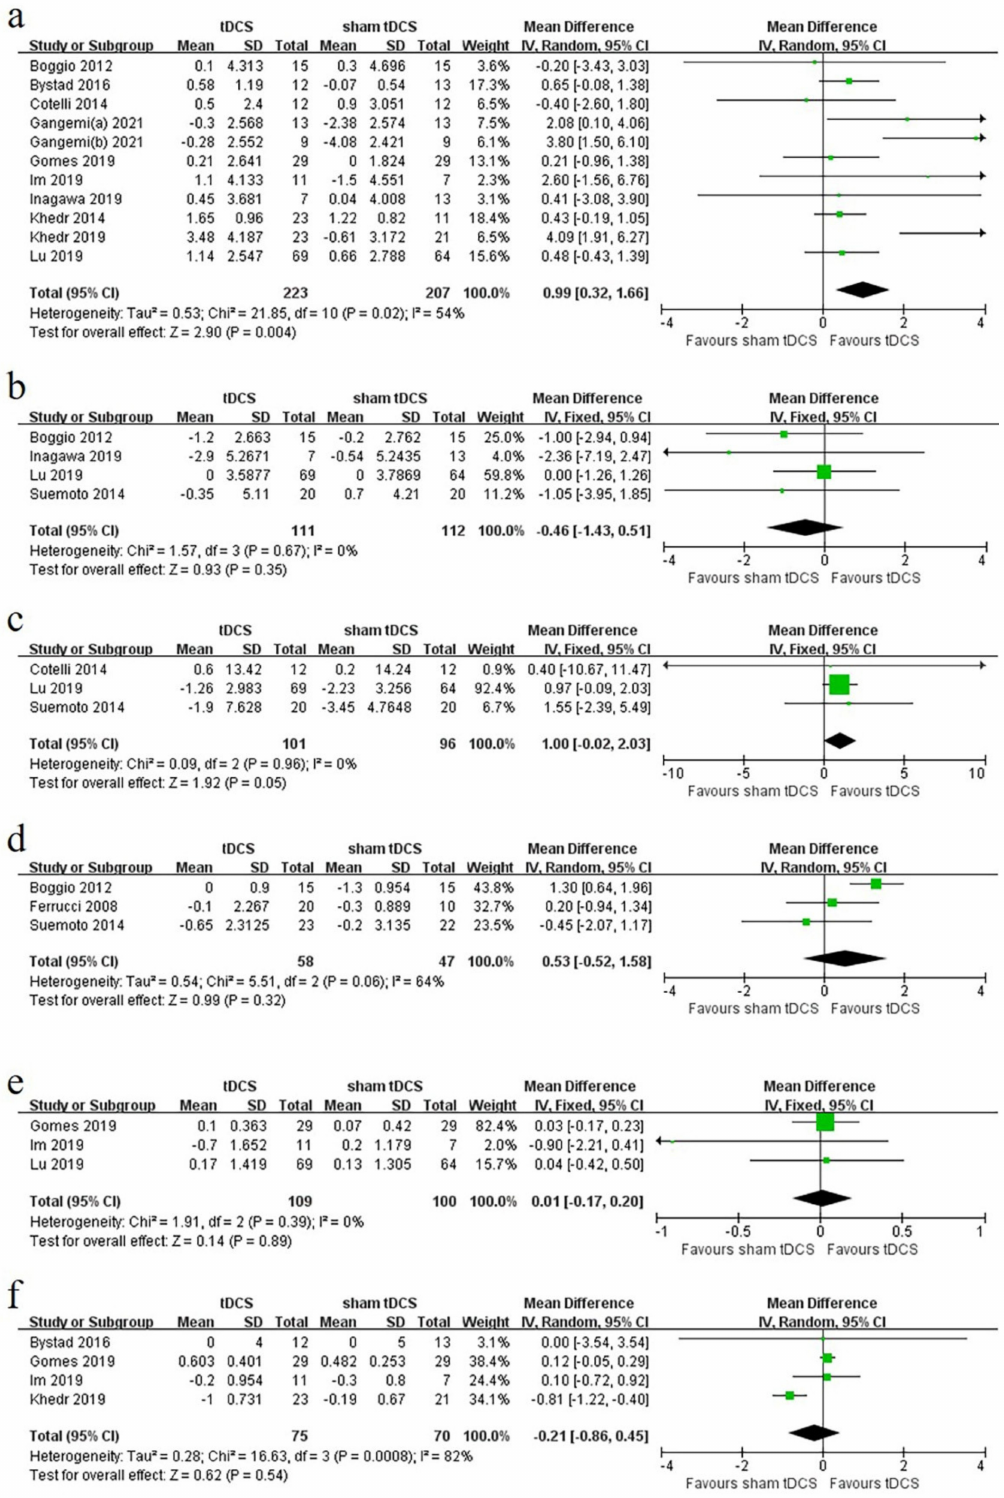
Figure 2. Forest plots of mean change from baseline, based on different scales: ( a ) Mini-Mental State Examination (MMSE), the order of references is [37,38,40,40–42,44–46,51]. ( b ) Alzheimer’s Disease Assessment Scale–Cognitive Subscale (ADAS-Cog), the order of references is [43,46,49,51]. ( c ) Neuropsychiatric Inventory (NPI), the order of references is [38,46,49]. ( d ) word-recognition task, the order of references is [17,49,51]. ( e ) Forward Digital Span (FDS), the order of references is [41,42,46]. ( f ) Clock Drawing Test, the order of references is [37,41,42,45]. Independent studies in the same literature are distinguished by ( a , b ). Error bars are 95% confidential